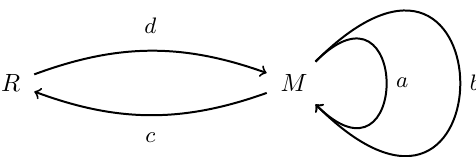
Figure 4 . Quiver for the NCCR of Laufer’s example with n = 1 [19]. For n > 1 one must add an extra loop at R